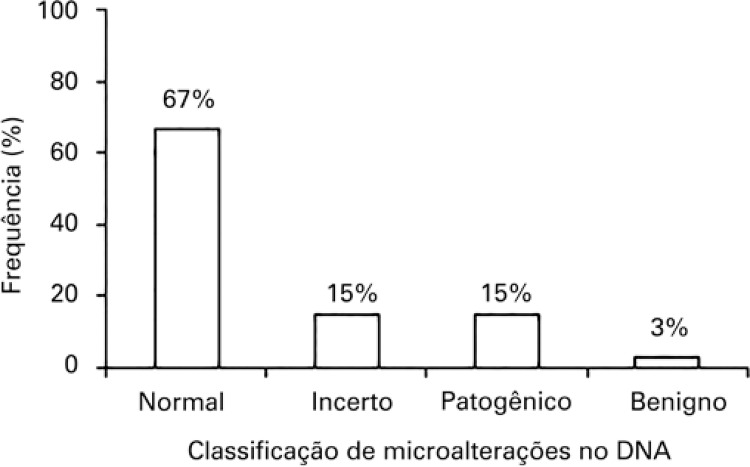
Resultados de exame de aCGH em pacientes com deficiência intelectual e dismorfias que possuíam cariótipo normal